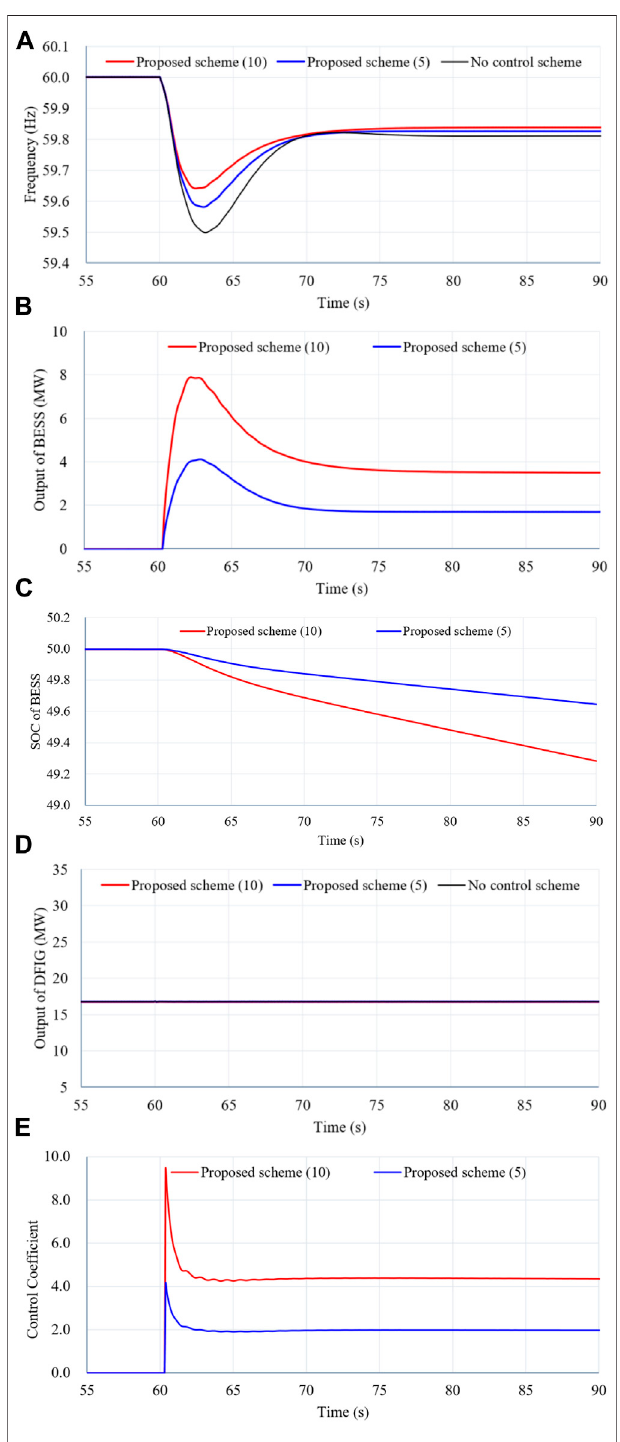
FIGURE9| ResultsforCase1. (A) Systemfrequency. (B) Output power of the BESS. (C) SOC ofthe BESS. (D) Output power ofthe DFIG. (E) Control coef fi